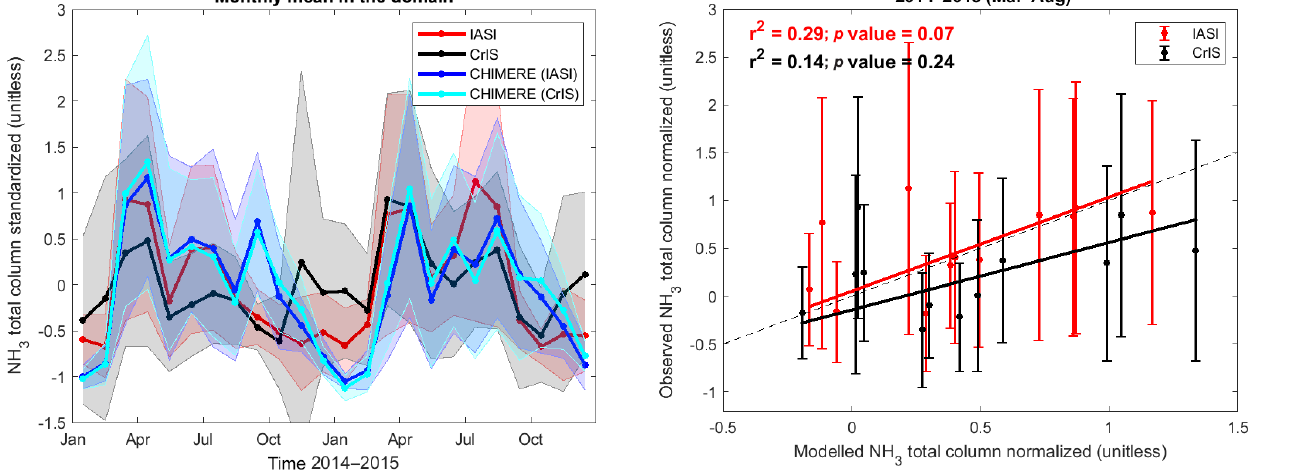
Figure 6. Standardized monthly mean concentrations derived from IASI (red), CrIS (black), CHIMERE sampled at IASI overpass time and space (blue), and CHIMERE sampled at CrIS overpass time and space (cyan) for 2014 and 2015. Shaded areas correspond to the 1 σ standard deviation around each mean.